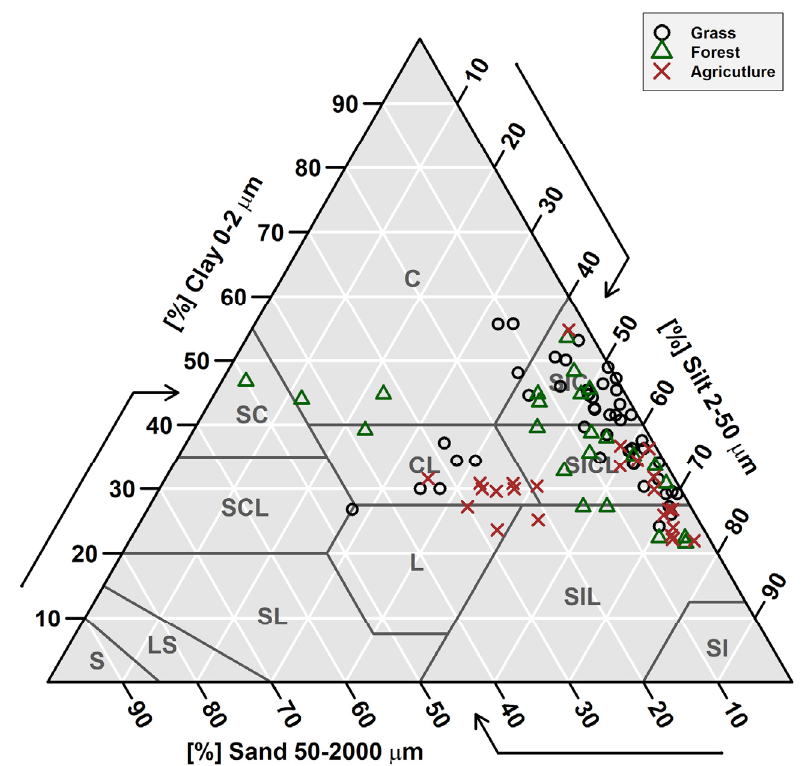
Figure 2. Soil texture pyramid for the study sites showing the dominance of silty clay (SIC) and silty clay loam (SICL) soils. Data represents soil texture for every soil depth sampled for each site. C = clay, SC = sandy clay, SCL = sandy clay loam, SL = sandy loam, LS = loamy sand, S = sand, L = loam, CL = clay loam, SIL = silt loam, and SI = silt.